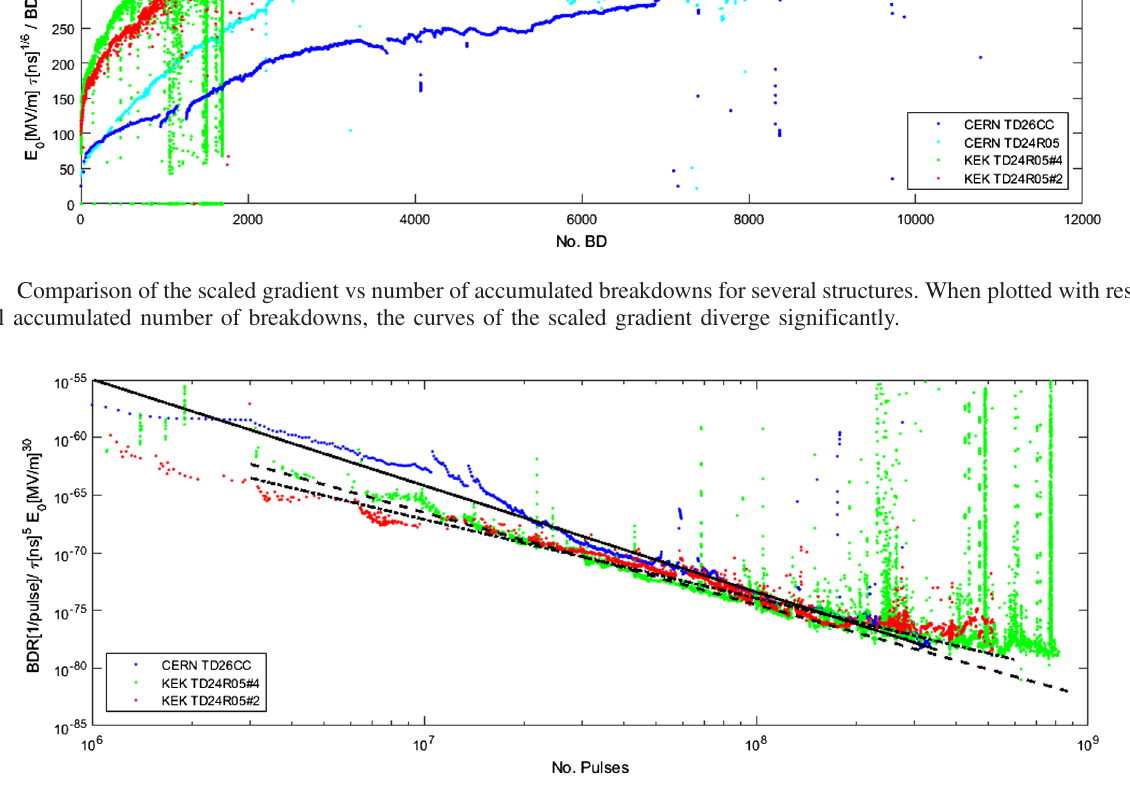
FIG. 5. Comparison of scaled BDR for different structures. The data are plotted in a log-log scale. The scaled BDR is decreasing monotonically with respect to the number of pulses. The curves are fitted with a power law.